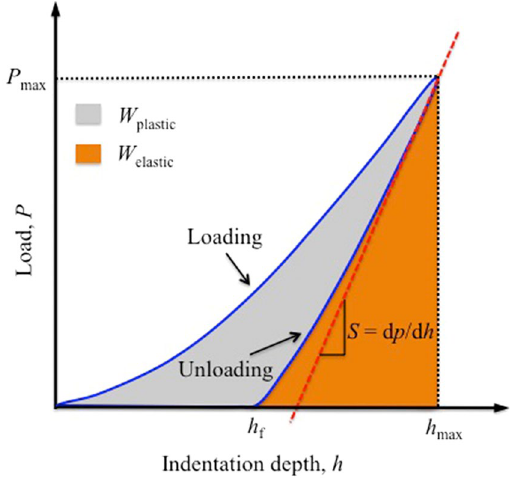
Figure 2. Schematic P - h curve for Berkovich indentation. P max is the maximum indentation load, h max is the maximum indentation depth, h f is the final depth, the elastic strain energy W elastic is the area under the unloading curve, and the indentation absorbed energy W plastic is the area under the loading